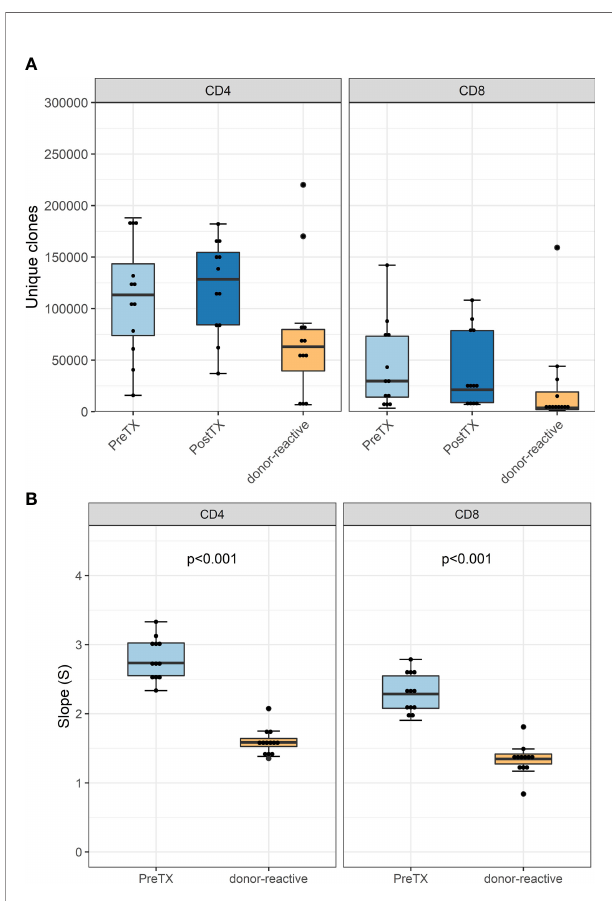
FIGURE 2 | (A) Absolute number of unique clonotypes grouped by phenotype groups CD4 and CD8 for the pre-transplant and the donor-reactive repertoire samples. (B) Boxplot of the computed absolute values of the power law slopes grouped by phenotype groups CD4 and CD8 for the unstimulated and donor- reactive repertoire samples. This decrease in absolute values of the power law slope re fl ects a reduced diversity of the donor-reactive repertoire for CD4 and CD8 positive cells (n = 12). Power law slopes for every individual and timepoint are shown in Supplementary Figures 1, 2